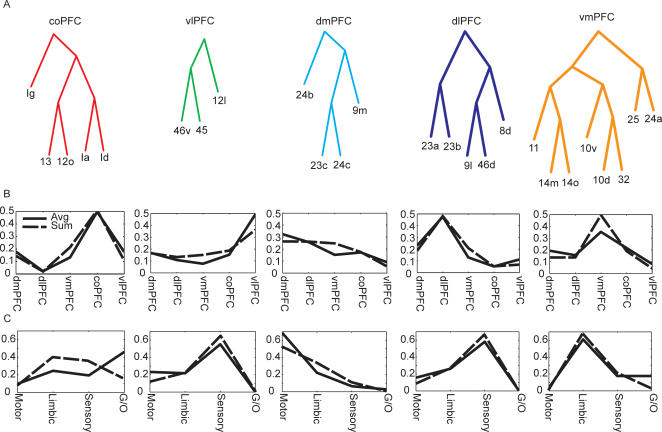
Profile of inputs characterizing each cluster of areas.(A) Clusters. (B) Intrinsic, frontal inputs. (C) Extrinsic inputs. All inputs were normalized to sum to 1. Thus, the line indicates the proportion of inputs coming from each modality.